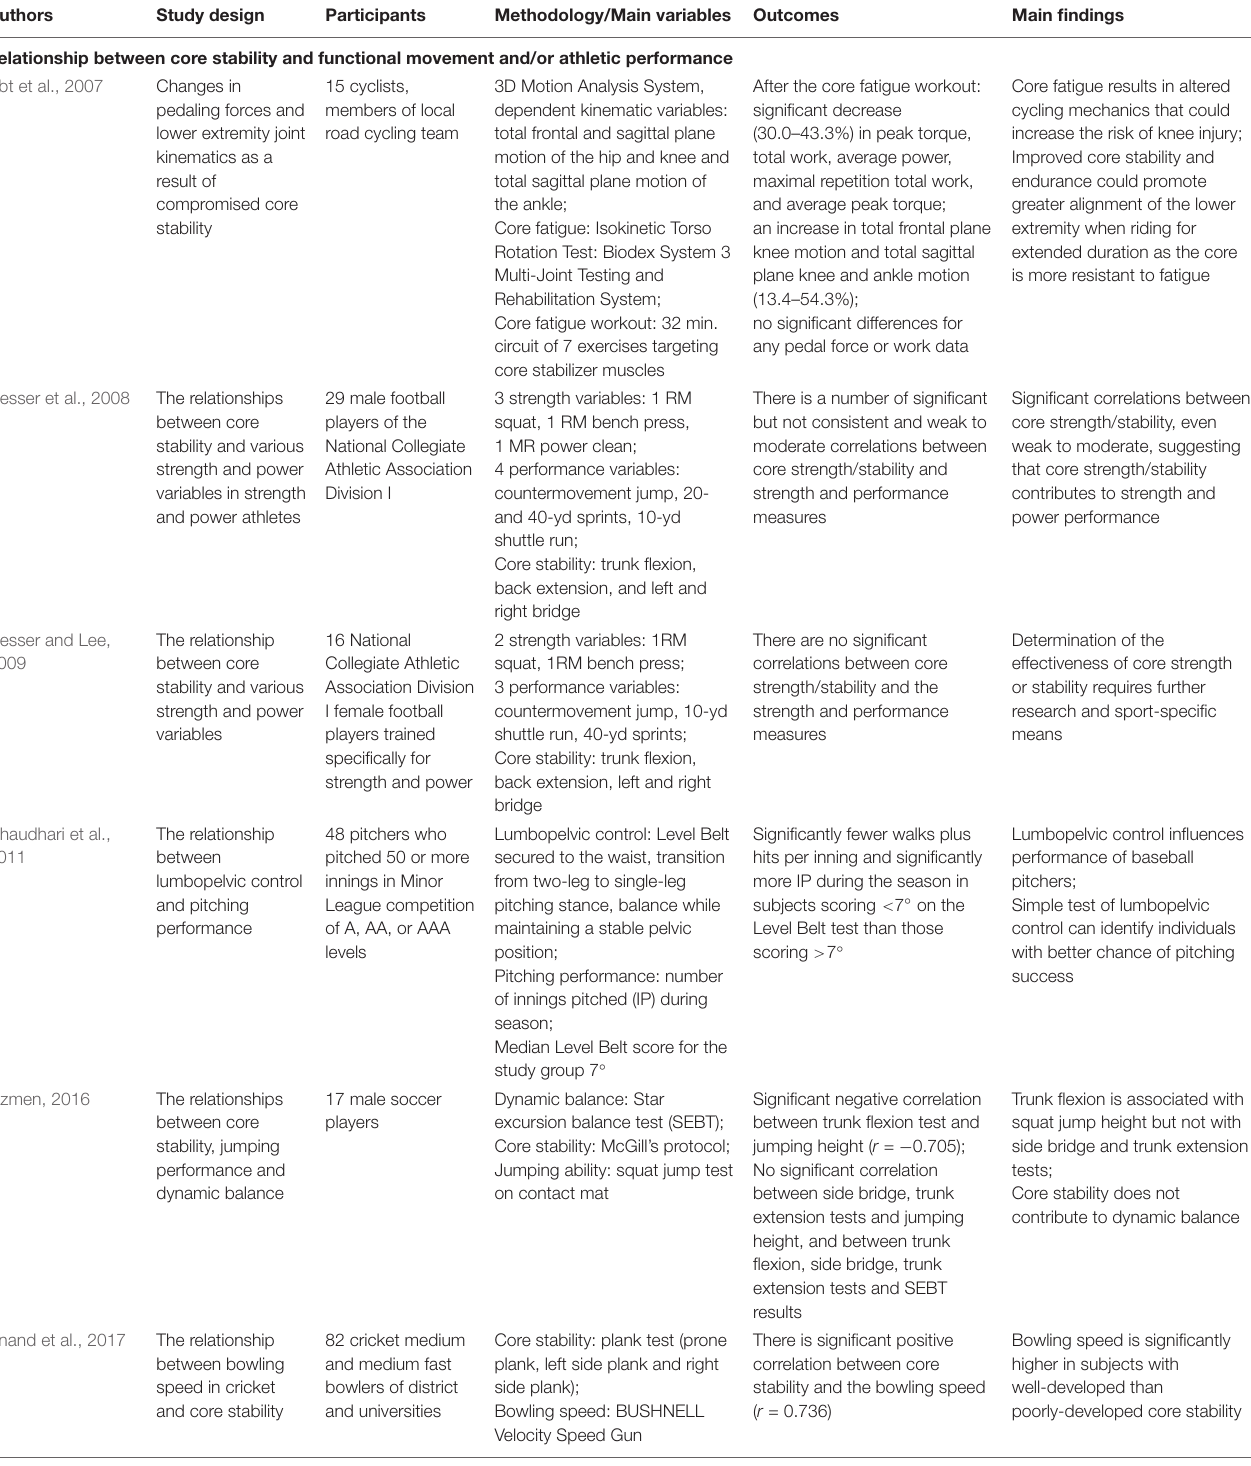
TABLE 2 | Neuromuscular control of core stability and functional movement and/or athlete